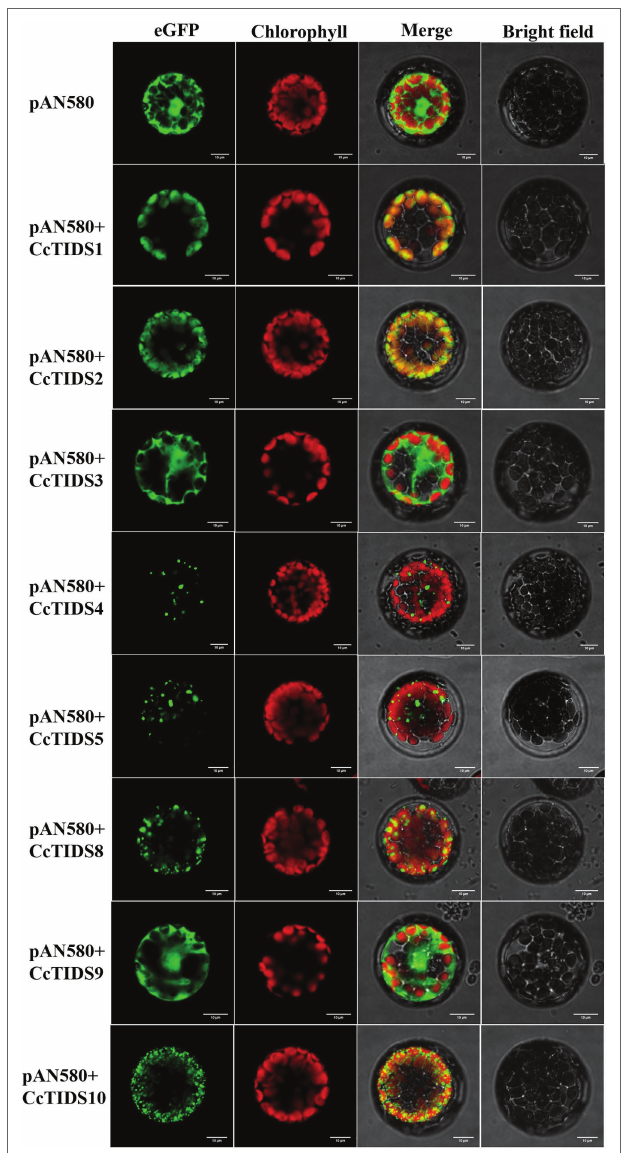
FIGURE 6 | Subcellular localization of eight putative C. camphora trans- prenyltransferase (CcTIDS) enzymes in A. thaliana protoplasts. eGFP, green fluorescent protein fluorescence image; chlorophyll, chlorophyll autofluorescence image; bright-field, transmission image; merged, all channels (eGFP, chlorophyll, and bright-field)